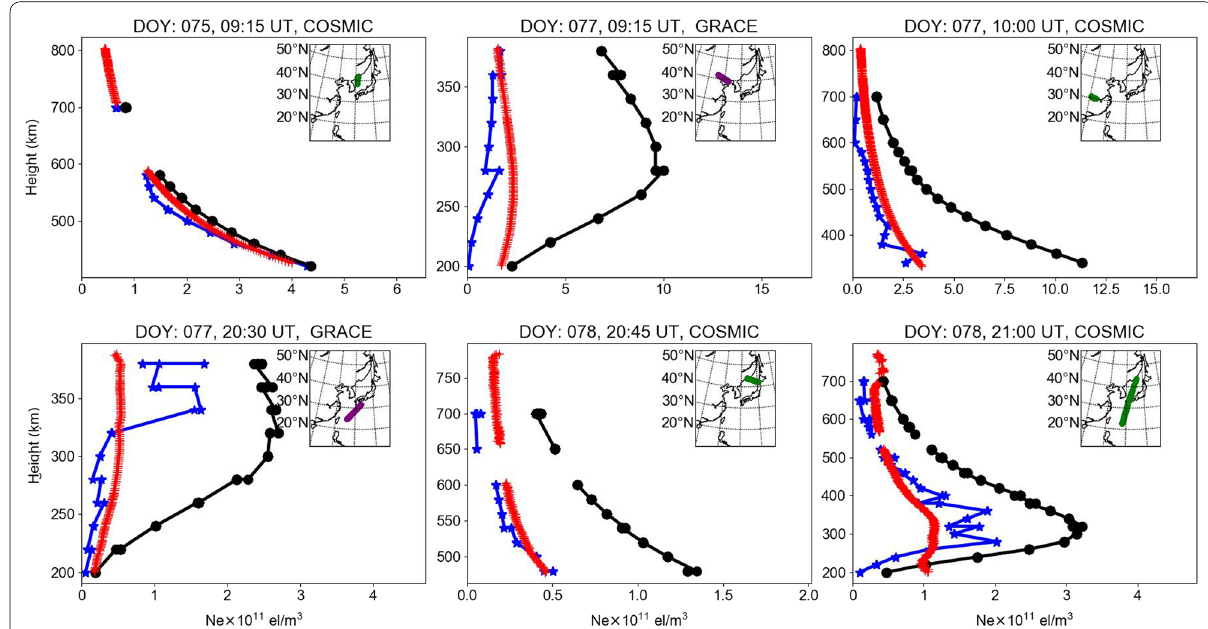
Fig. 6 Comparison of radio occultation (RO) to IRI model (black)/reconstructed (blue) density profiles during the 2015 St Patrick’s day geomagnetic storm. Comparison is performed along the trace of RO tangent points shown on maps in the upper right corner of each subplot (purple: GRACE, green: COSMIC). DOY 076 is not presented because the data points were few. Also, we limit the analysis to regions where RO density profiles have good accuracy (away from the low latitudes and altitudes above 200